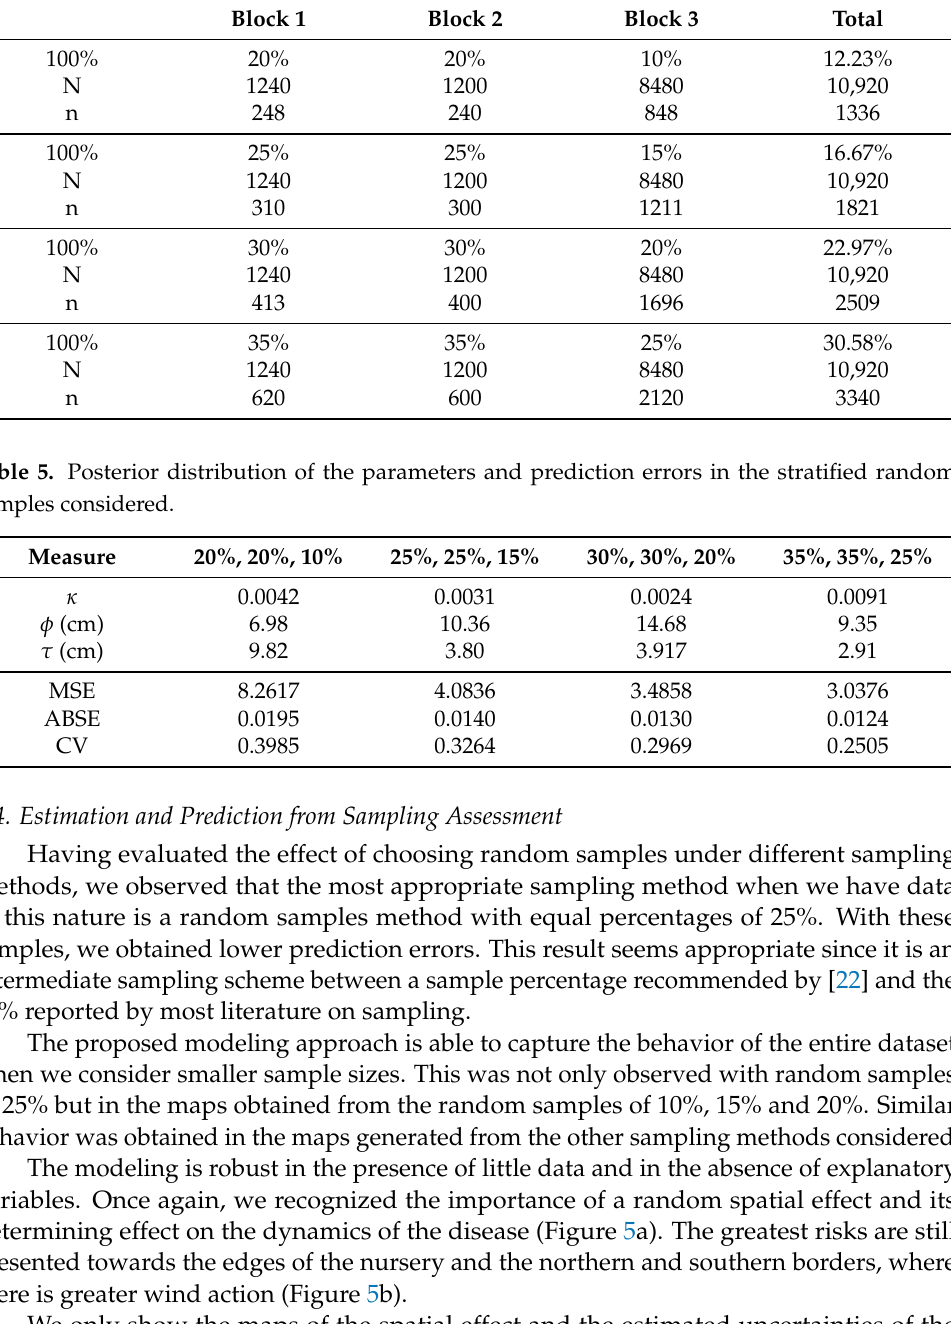
Table 4. Percentages used in the stratified random sampling method.